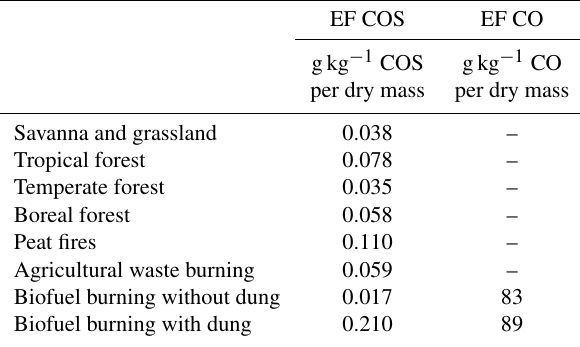
Table 2. Biomass burning emission factors used in converting COS emissions. EF COS denotes the COS emission factor from dry mass in units of gkg − 1 COS per dry mass, and EF CO denotes the CO emission factor in gkg − 1 CO per dry mass. Emission factors were taken from Andreae